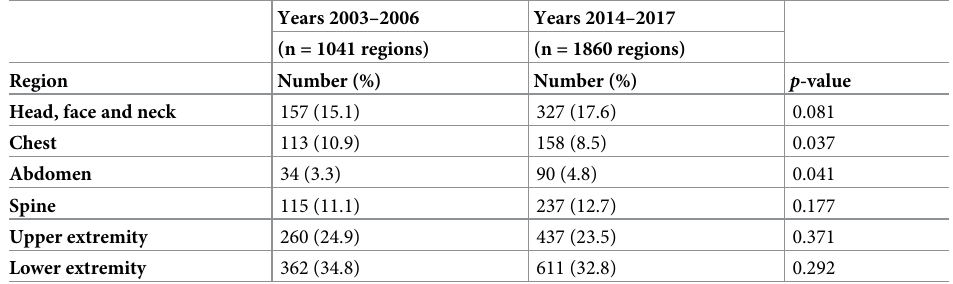
Table 3. Anatomical distribution of fall-related injuries during the first (2003–2006) and second period (2014–